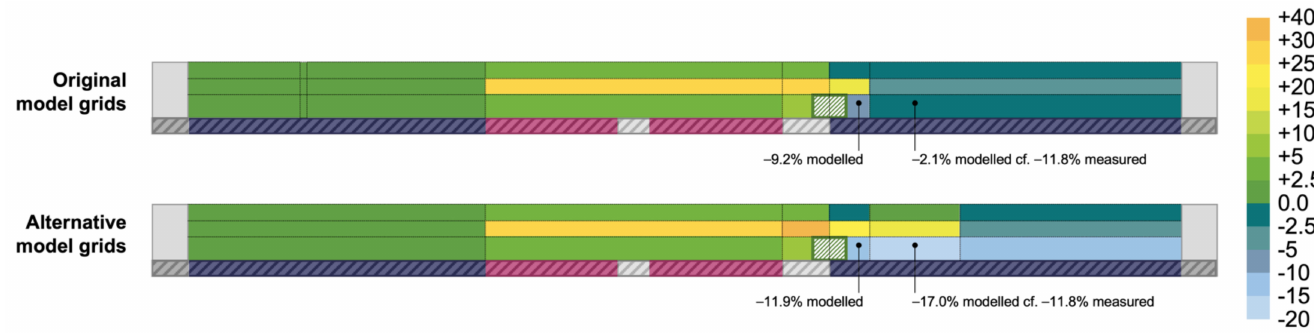
Figure 13. Modelled changes in NO 2 mass concentration (%), on introducing a roadside barrier in an open-road environment, as we seek to emulate [50]’s measurements beside Interstate-280 in the